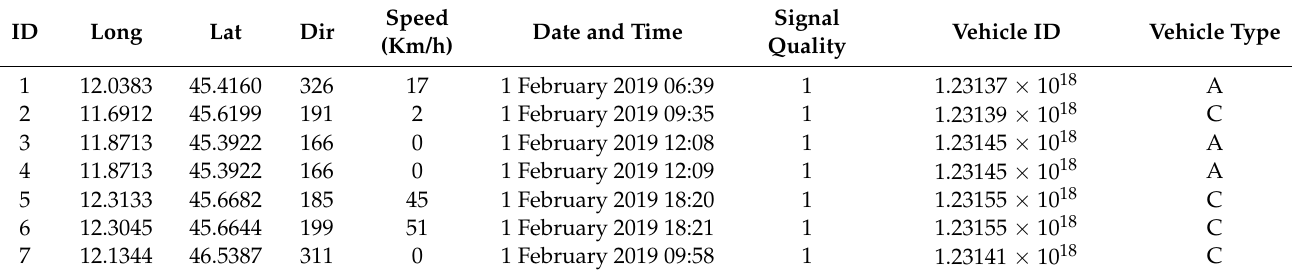
Table 2. Example of Historical Car Data information.